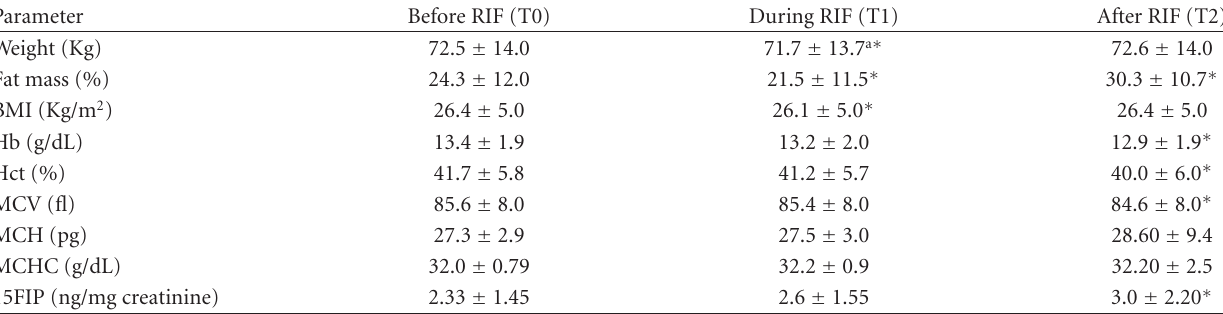
Table 3: Values of anthropometric, hematological and 15FIP before, during, and after